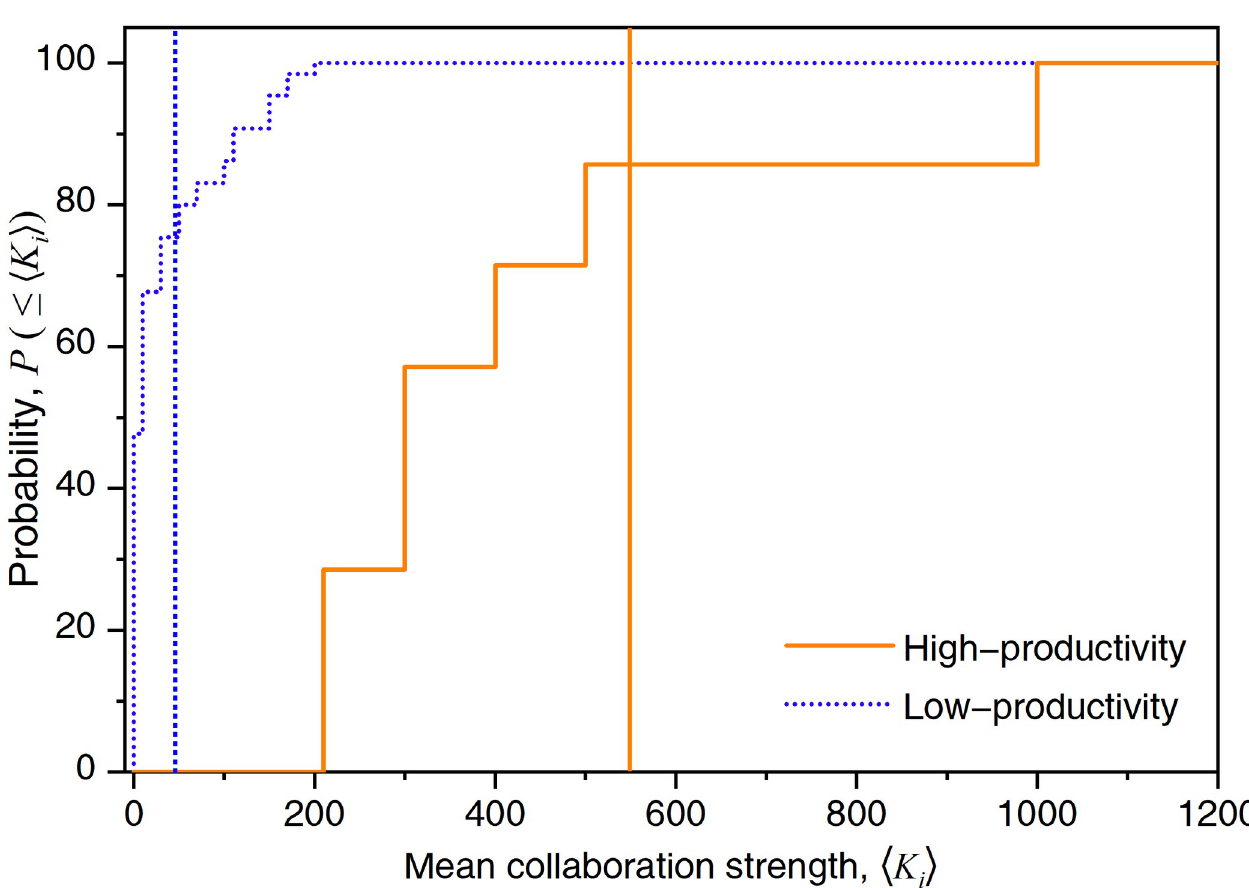
Fig 4. Cumulative distribution of mean collaboration strength h K i i .